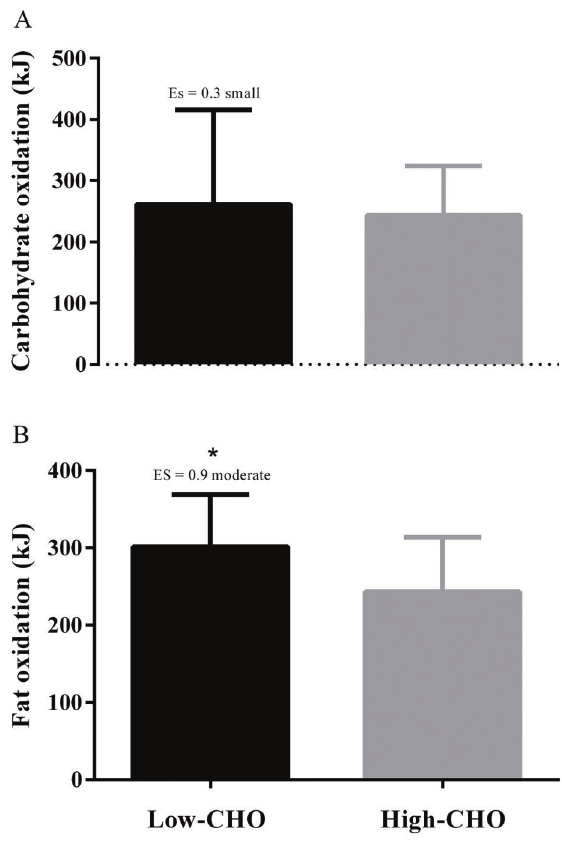
Figure 3. Total carbohydrate (CHO) ( A ) and fat ( B ) oxidation throughout recovery of a single, high-intensity exercise bout . ( B 95% VO 2max ) performed under low- and high-CHO availability. Data are reported as means ± SD (n=8). *P o 0.05 compared to high-CHO availability, moderate effect size (ES=0.9) ( t -test).